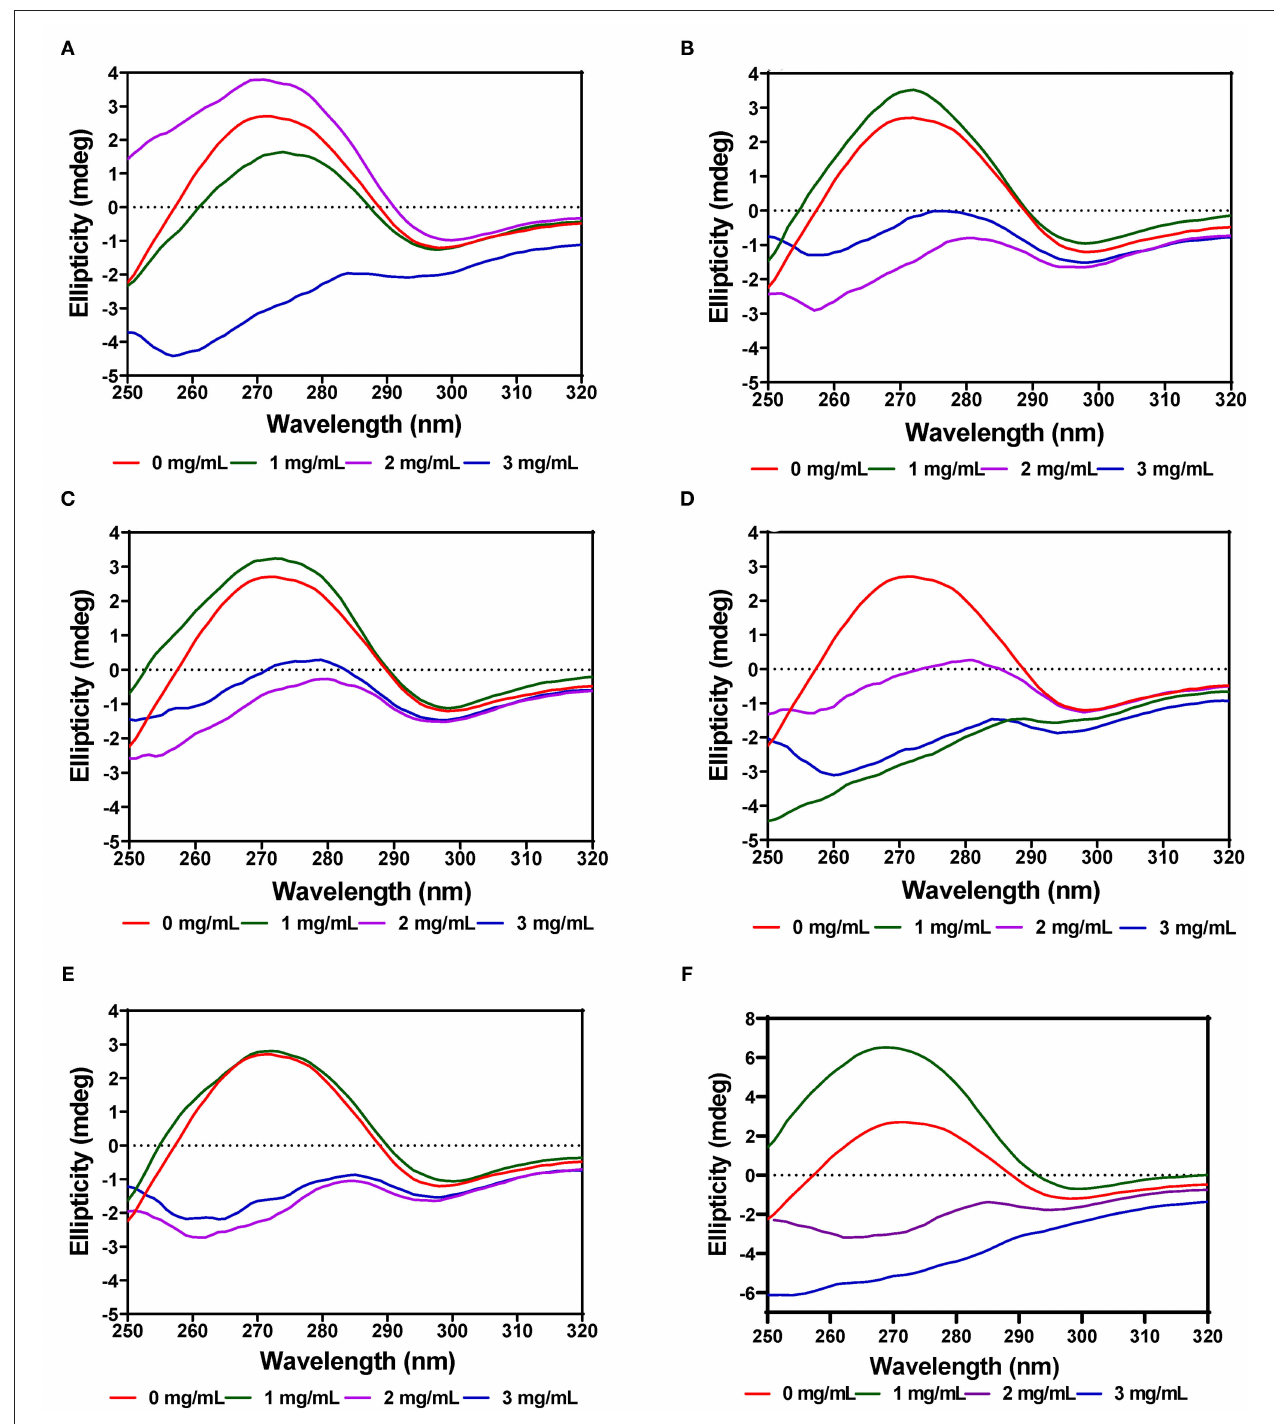
FIGURE 8 | Near-UV CD of pancreatic lipase in the presence of varied concentrations of leaf extracts from: (A) AV-40-T1, (B) AV-40-T2, (C) SM-40-T1, (D) SM-40-T2, (E) TO-40-T1, and (F) TO-40-T2. Plants were produced with nitrogen fertilizer (40 kg/ha), which was applied at (T1) or after (T2) planting.